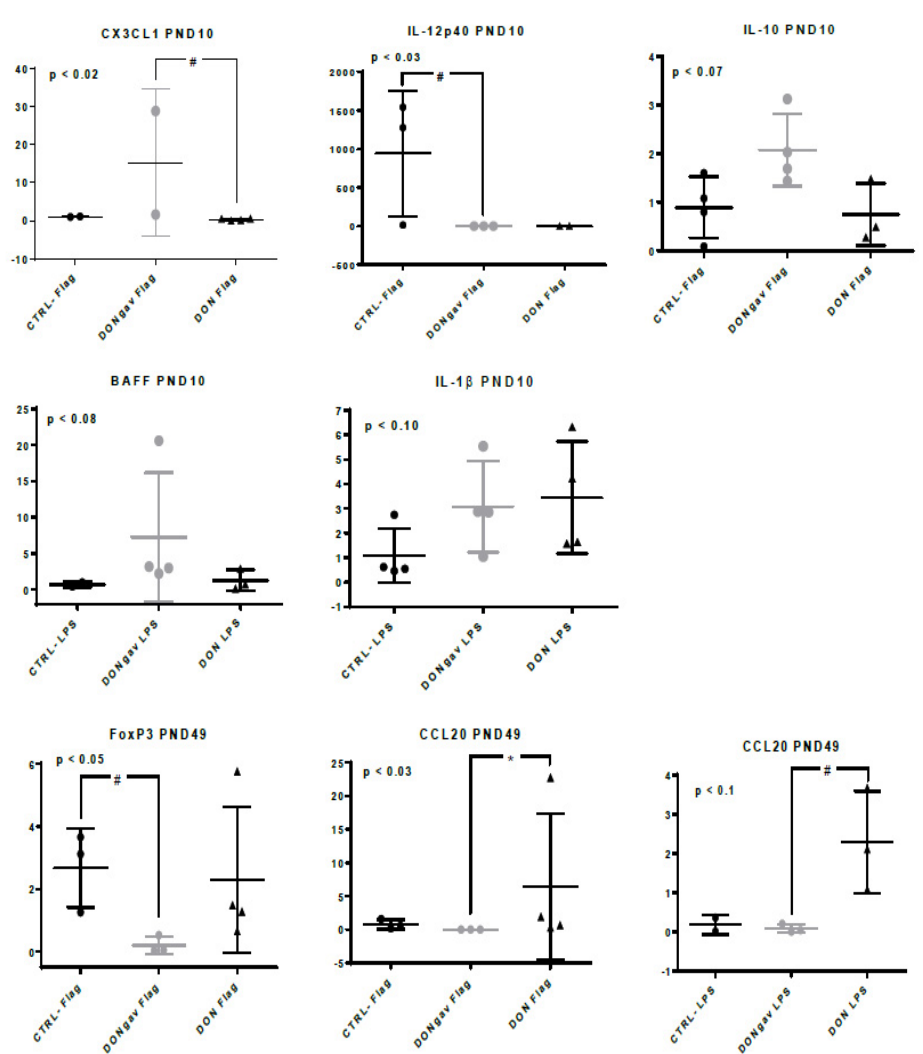
Figure 9. Sow diet mycotoxin contamination (DON) and neonate mycotoxin gavage (DONgav) e ff ect on gene expression of jej-LP explants stimulated with TLR-ligands. Datasets were analyzed using the non-parametric Kruskal-Wallis test (p-value on left corner of each graph) followed by Dunn’s multiple comparison tests when appropriate. Jej-LP explants of CTRL- ( n = 2–4, full black circle), DONgav ( n = 2–4, empty grey circle) and DON ( n = 2–4, full black triangle) were stimulated with flagellin (1 µ g / mL) or with LPS (50 µ g / mL) at PND10, PND21 and PND49. Relative expressions of the target genes were determined using the 2 − ∆∆ Ct method. Di ff erences in stimulated jej-LP explant gene expression level between CTRL-, DONgav vs. DON are displayed with * p < 0.05 or # p <